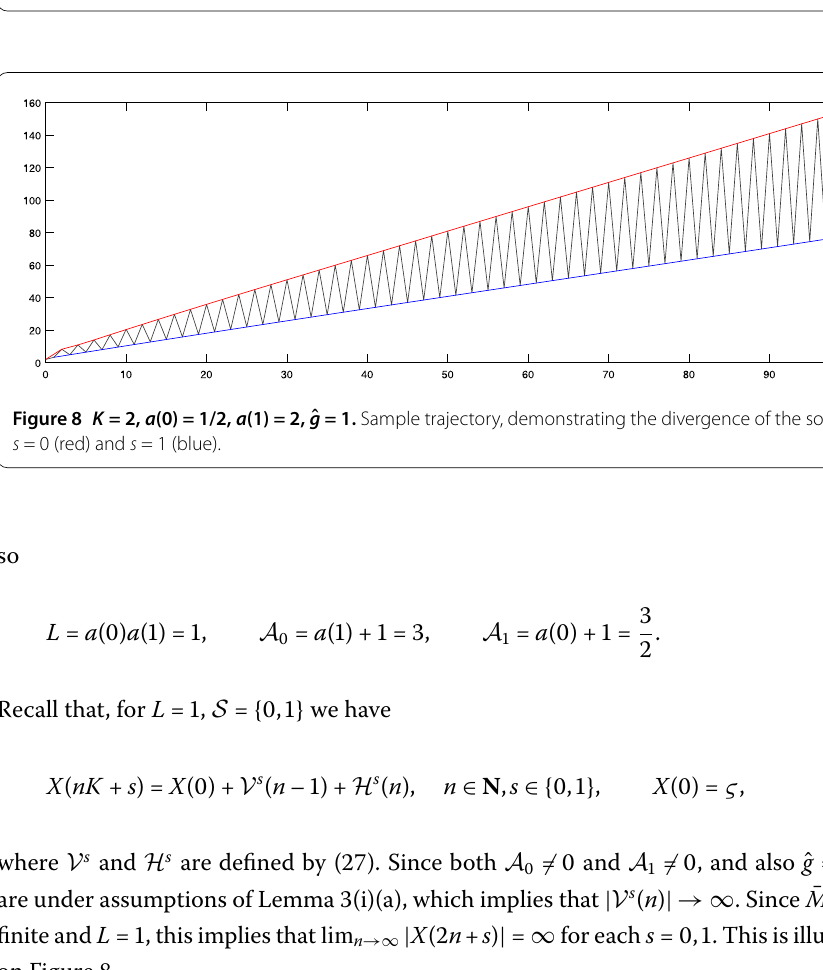
Figure 7 K = 2, a (0) = 1, a (1) = 1/2, ˆ g = 1. Ten trajectories, showing two nonrandom limits for s = 0 (red) and s = 1 (blue).